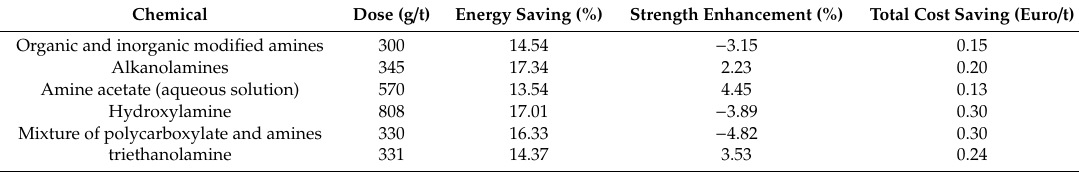
Table 7. E ff ect of chemical additives on the comminution energy and cement strength enhancement